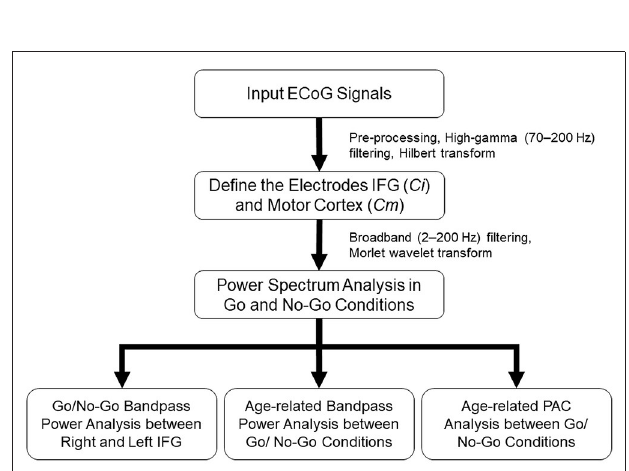
FIGURE 2 | Illustration of the flow chart of data analysis. After preprocessing the ECoG signal, high-gamma (HG) activation was applied to define the most activated electrode to represent inferior frontal gyrus (IFG) ( Ci ) and motor cortex ( Cm ). Broadband pass power spectrum was analyzed between Go and No-Go conditions. Finally, side-related bandpass power changed, as well as age-related bandpass power and phase-amplitude coupling (PAC) between Go and No-Go conditions were further